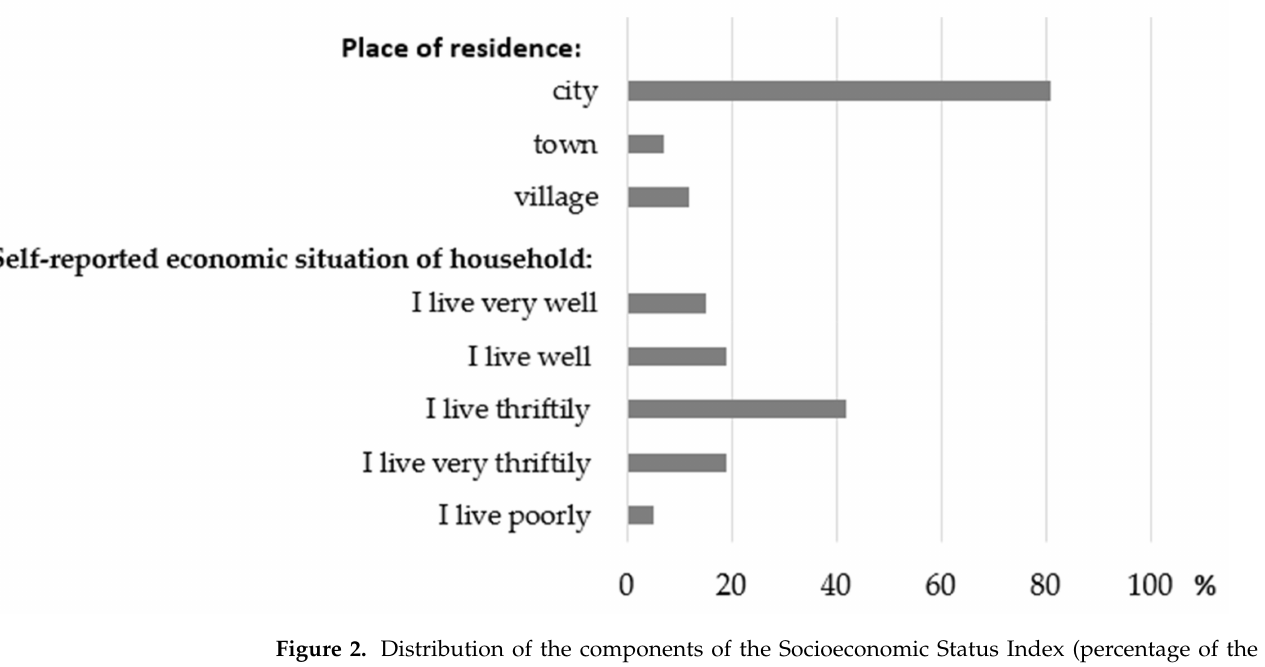
Figure 2. Distribution of the components of the Socioeconomic Status Index (percentage of the total sample).